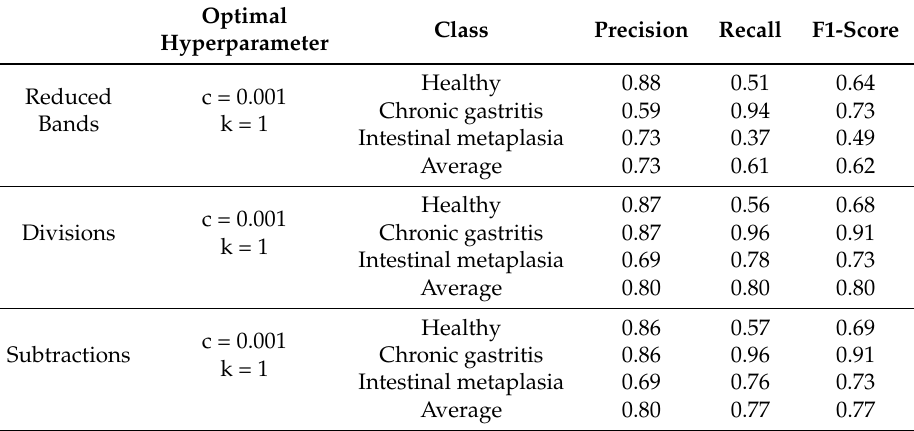
Table 3. Classification results with the NIR